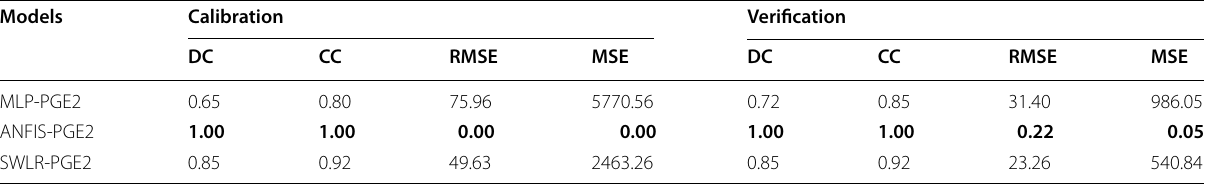
The best performing model are written in bold DC Determination co-efficient, CC =